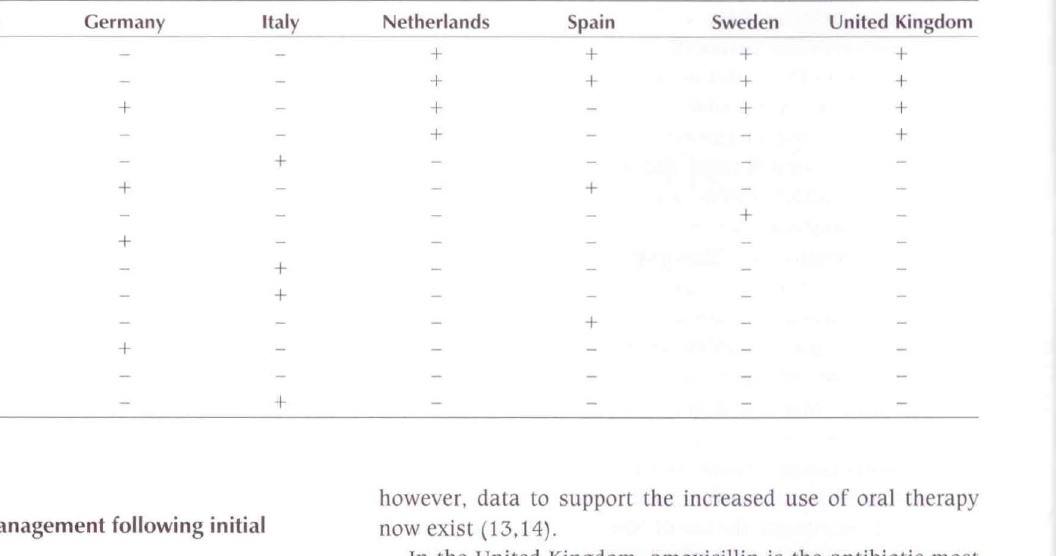
Community antimicrobial management following initial therapy failure